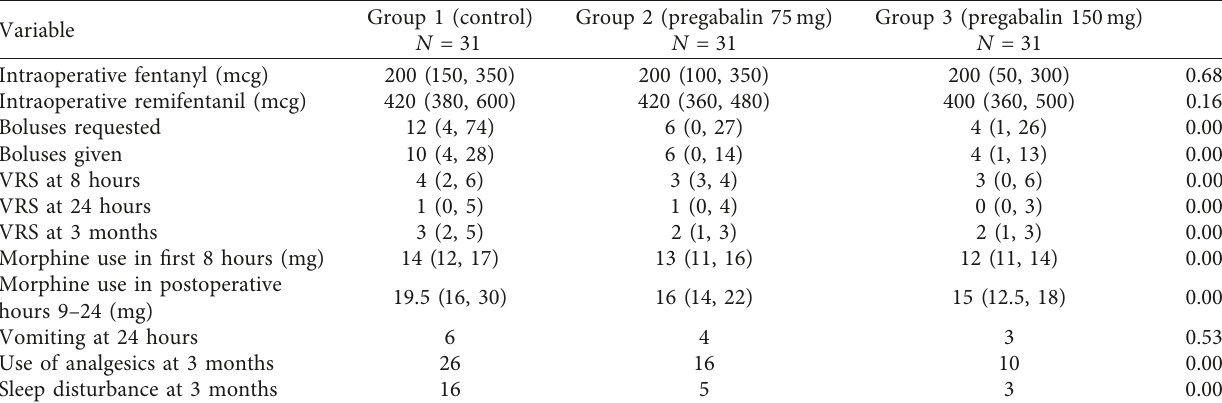
Table 2: Postoperative analgesic use and pain intensity. Data reported as median (minimum, maximum). Values for comparisons between study groups were calculated using the Kruskal–Wallis or chi-square tests as appropriate. Values for significance were adjusted to 0.05/12 � 0.0042 using Bonferroni correction for multiple